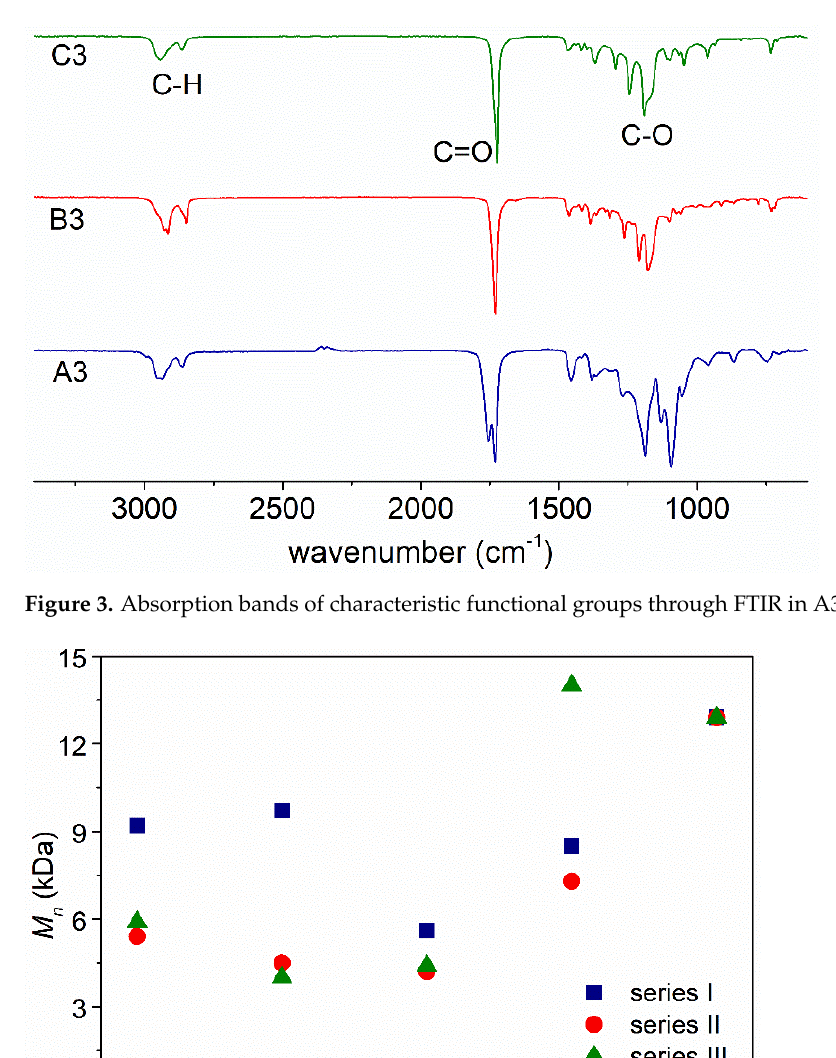
Figure 5. GPC analysis of polyesters of Series I ( A ), Series II ( B ) and Series III ( C ).